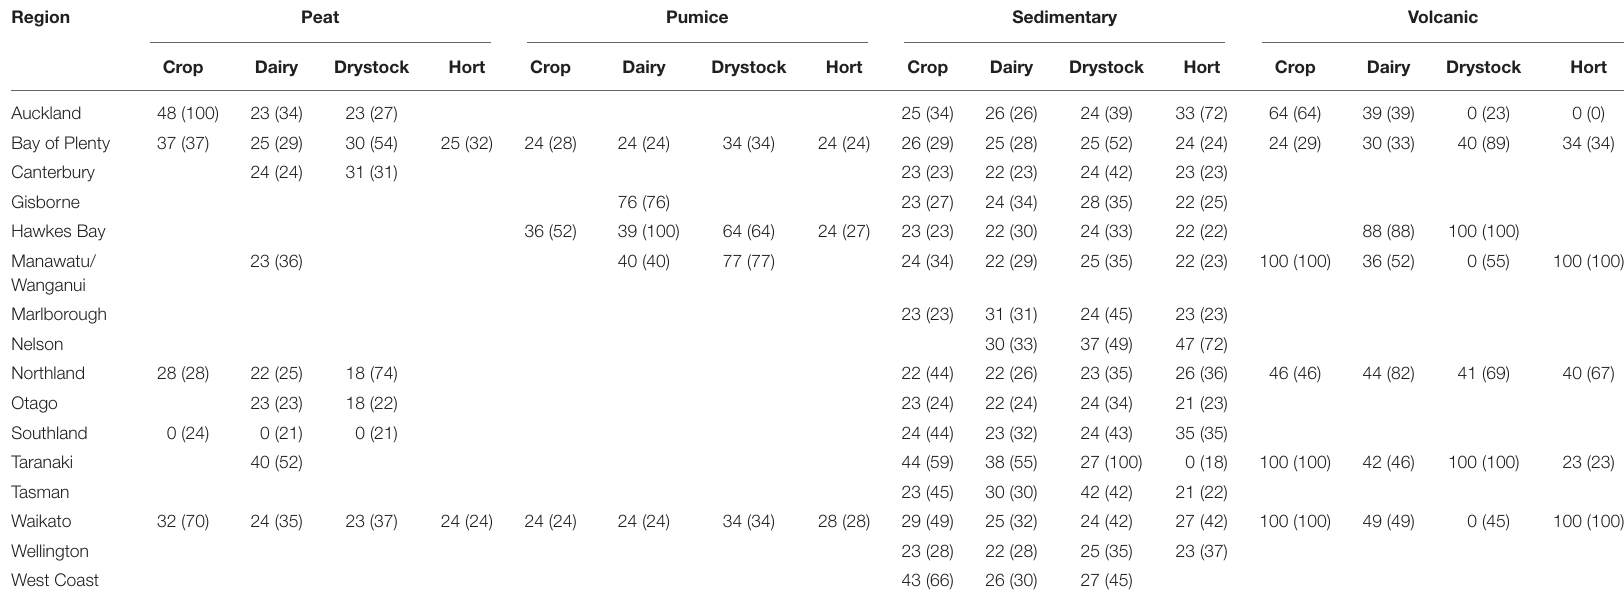
TABLE 4 | Median and the 75th percentile (in parentheses) of the time (years) taken for water extractable P (WEP) to decrease to environmental targets in each region by soil group by land use (Crop = Cropping, Hort = horticulture) combination if fertilizer P was withheld. Region Peat Pumice Sedimentary Volcanic Crop Dairy Drystock Hort Crop